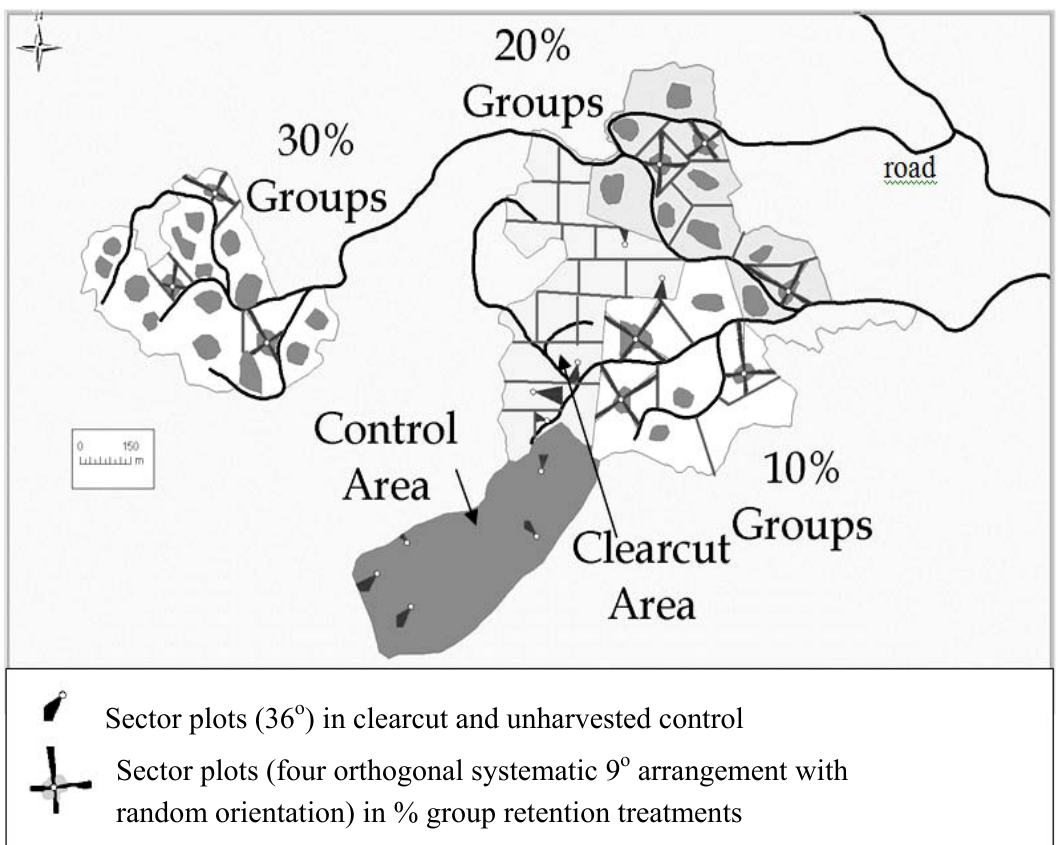
Figure 5. Schematic example of sector plot layout in an aggregated retention forested setting experimental area. The control area is unharvested, the clearcut area is harvested and the 10%, 20% and 30% groups have small groups of trees (approx. 0.3 ha in size) surrounded by harvested areas. “10% Groups” refers to 10% of the treatment area covered in retained groups, etc